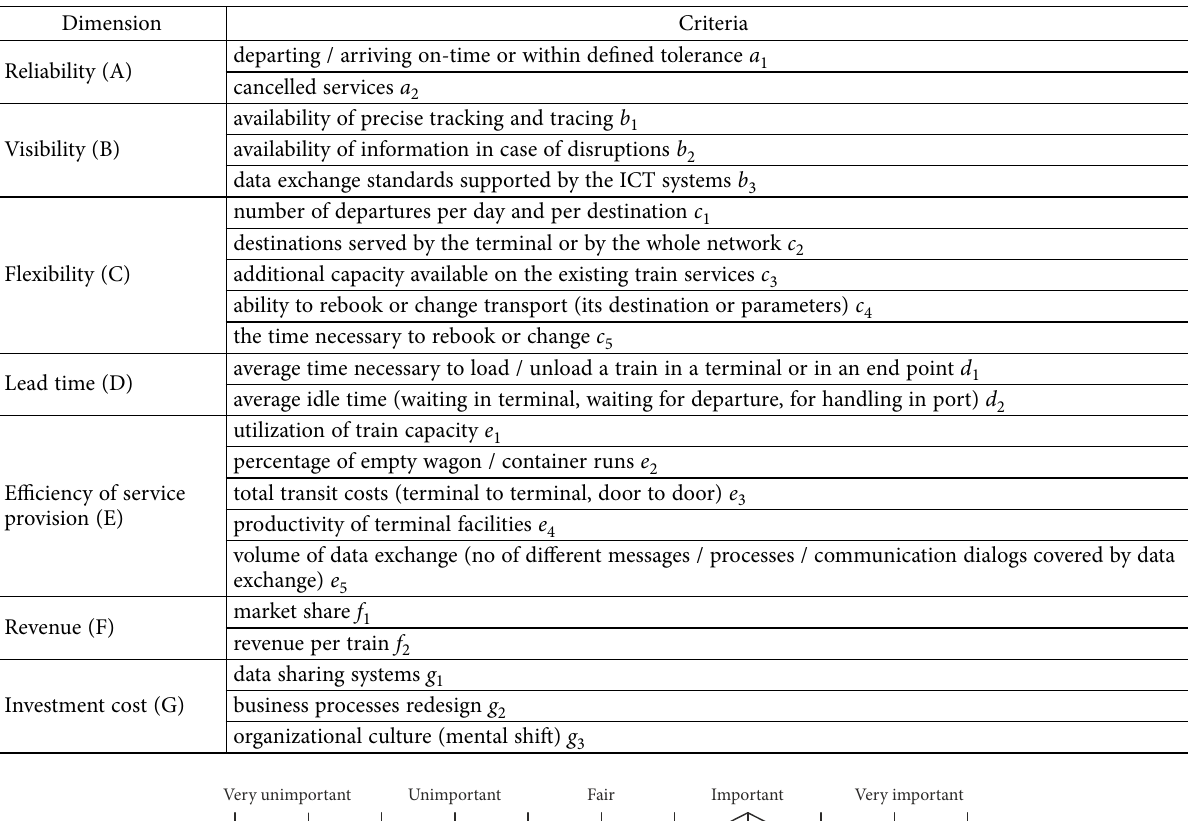
Figure 2. Rank of importance level (Chen et al. Preferred subset of Key Performance Indicators (KPIs) for improved rail intermodal transport chain